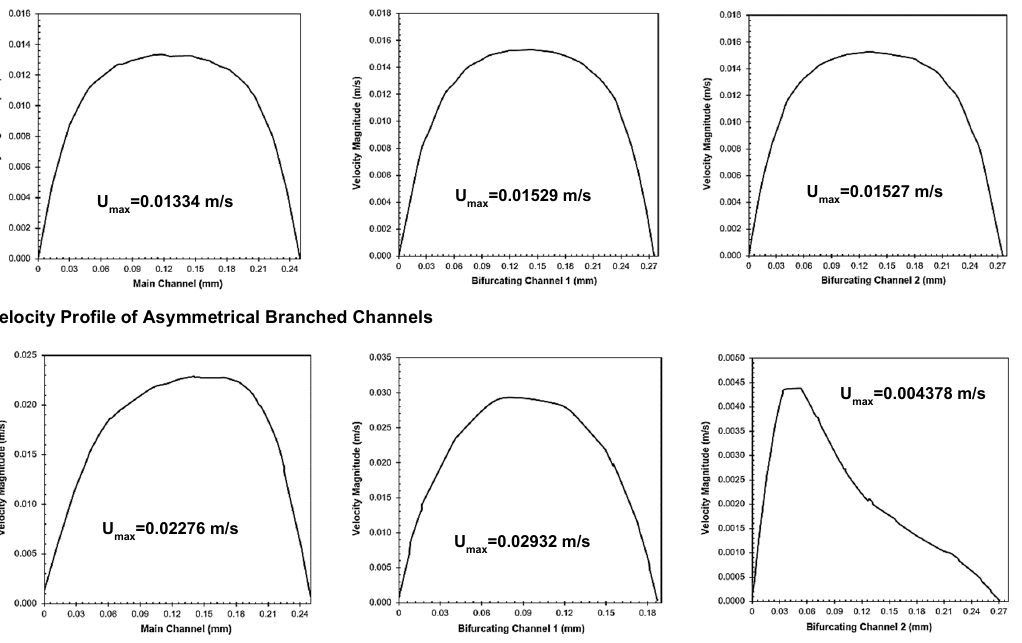
Figure 7. The simulated profile of velocity magnitude distribution along the direction of the continuous phase flow at the top layer of extended T-junction (for system: Q c = 2 mL/h). The numbers indicate locations at which image profiles were taken.